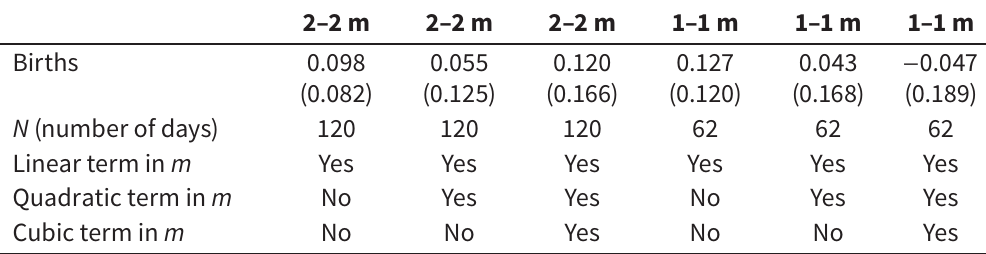
Discontinuity in births at the January 1 2011,